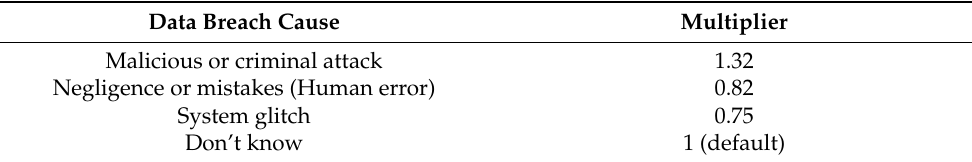
Table 15. Probability factor—data breach causes F BREACH_CAUSE .